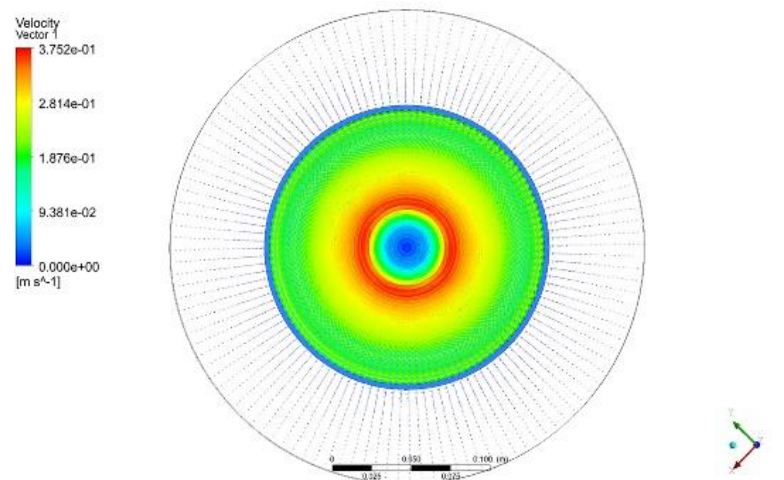
Figure 20. ( δ = 0.3, r = 1000).